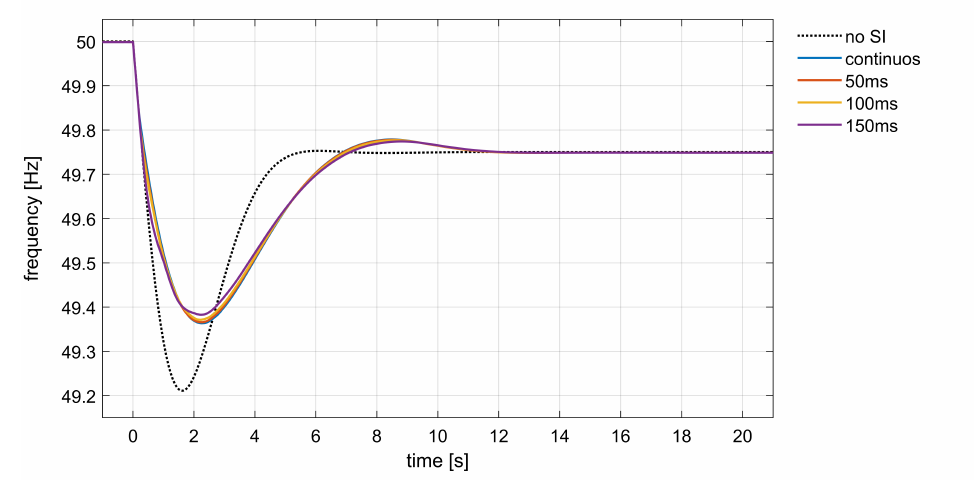
Figure 8. Ideal controller: frequency response with different RoCoF reporting time and K = 10.